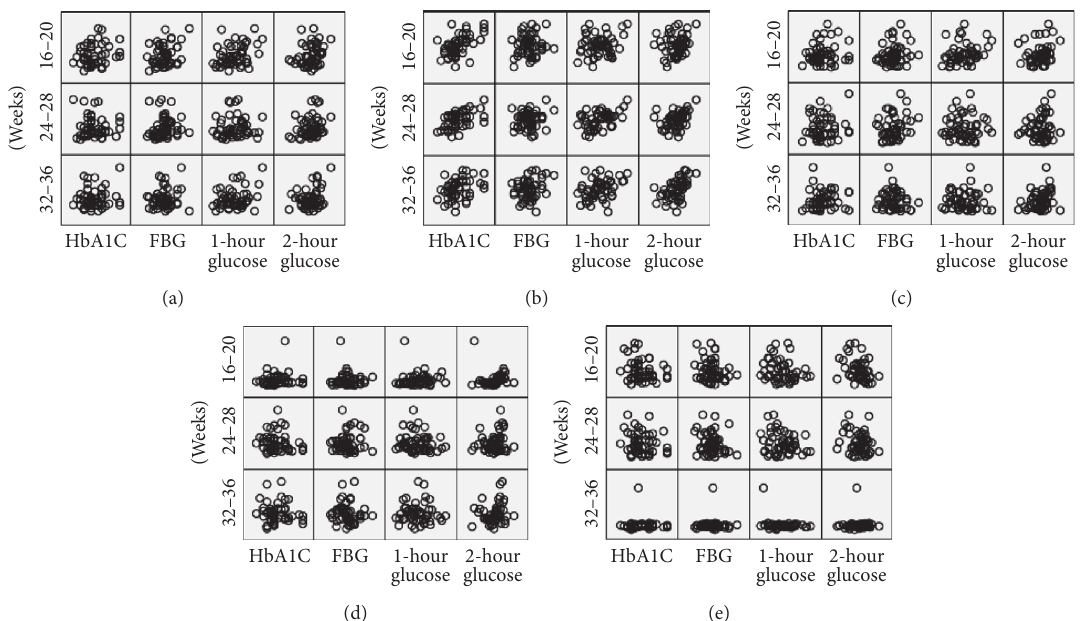
Figure 2: Relationships between PCO (a), AOPP (b), 8-iso-PGF2 𝛼 (c), GPX-3 (d), PON1 (e), and A1C and OGTT glucose level in GDM. FBG: fasting blood